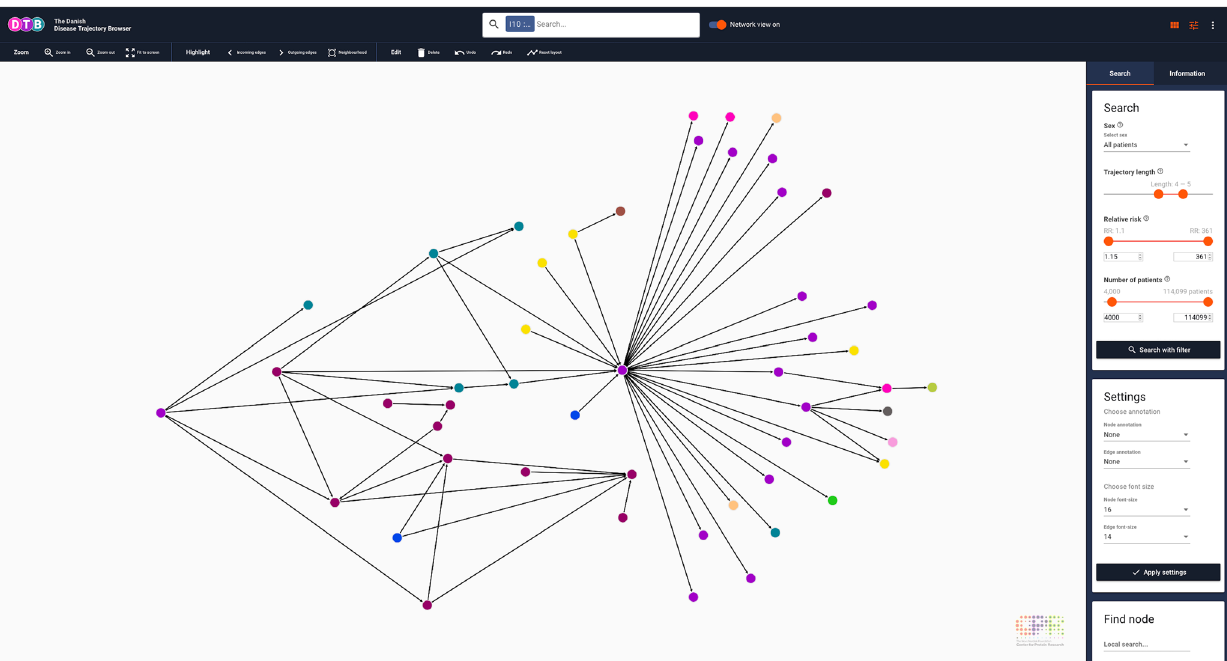
Fig. 5 Disease trajectory network for essential (primary) hypertension (I10). When the search tab is selected in the side panel, users can perform advanced DTB queries by application of DTB functionality, comprised of a the drop-down menu (All patients, female patients only or male patients only), notches (trajectory length, relative risk and number of patients) or fi elds for typing the boundary values (relative risk and number of patients). Users can customise the layout of the search results by selecting annotation (type and font) and perform a local search by typing an ICD-10 code or a disease (bottom, left corner). Search fi lter setting: all patients, length 4 – 5, RR 1.15 – 361, number of patients 4000 – 114,099. DTB Danish Disease Trajectory